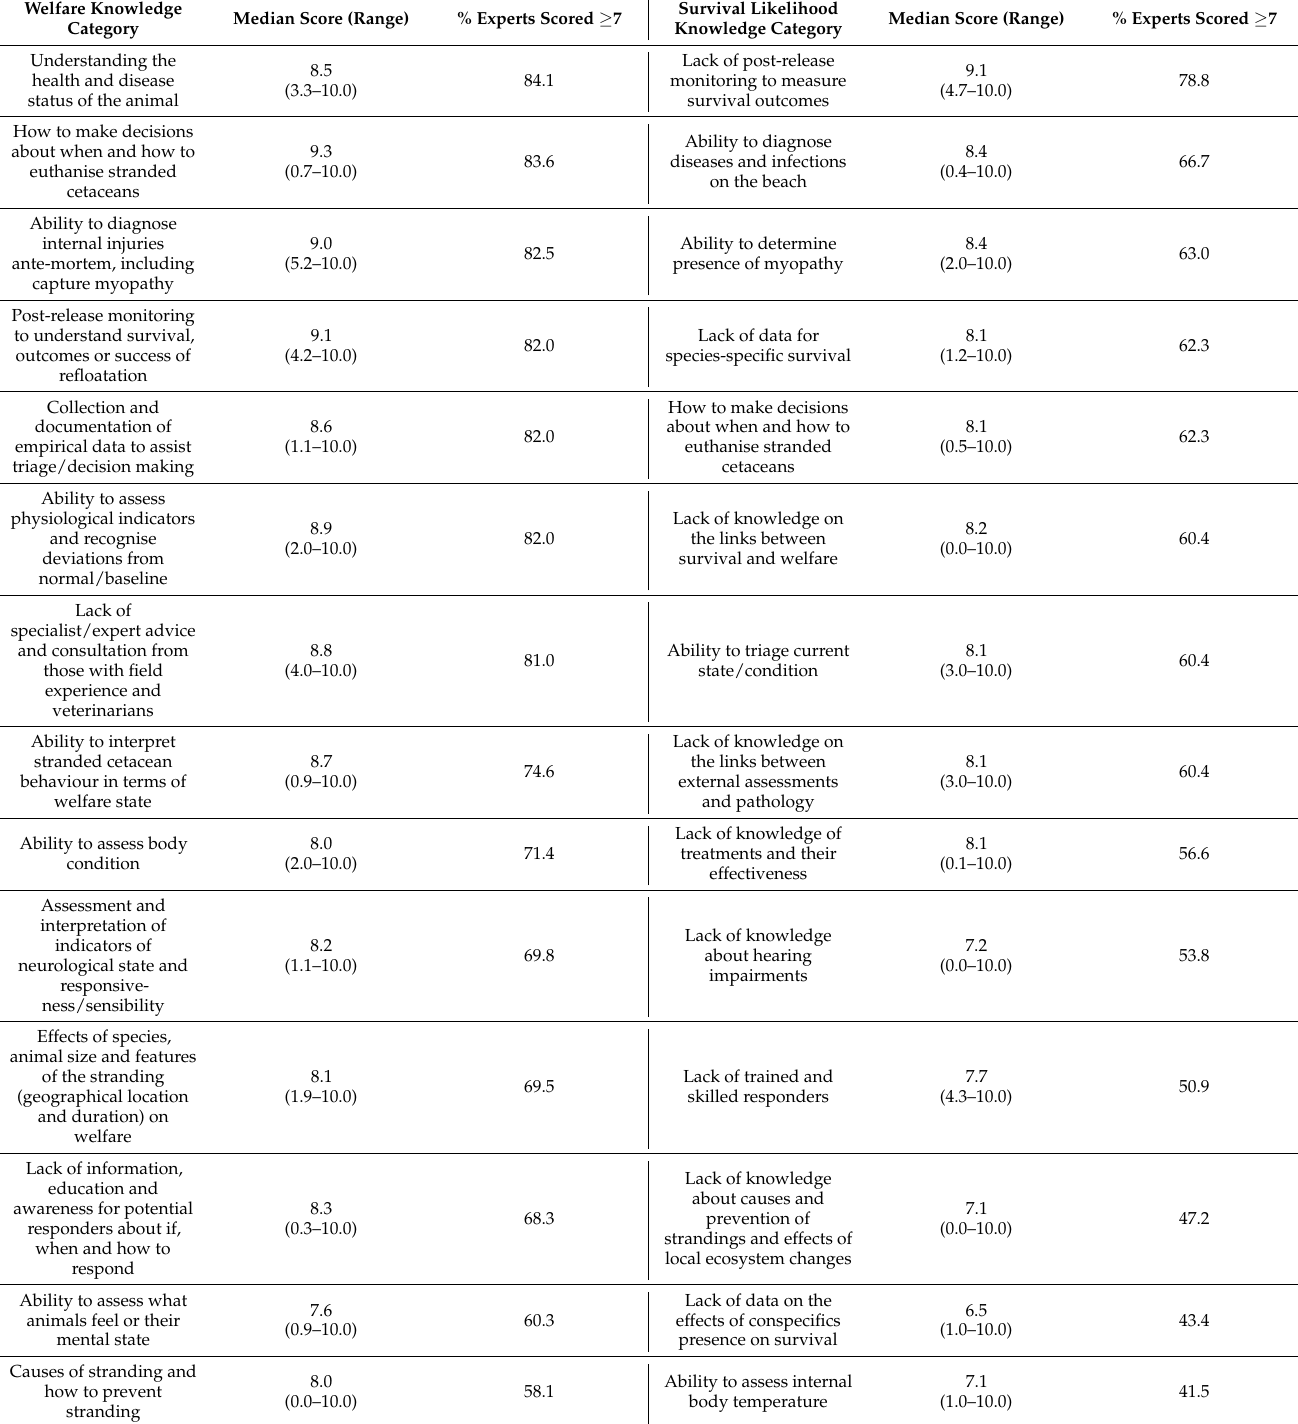
Table 2. The major categories for knowledge gaps, that if addressed, would greatly improve the ability to assess stranded cetacean welfare and survival likelihood arising from reflexive thematic analysis of participant responses to questionnaire 1, and median score and range for each category from questionnaire 2. Categories are ranked by the percentage of experts that strongly agreed that filling the knowledge gap would improve the ability to assess welfare/survival likelihood (scores in ≥ 7 grouping). Categories above the bold line reached consensus ( ≥